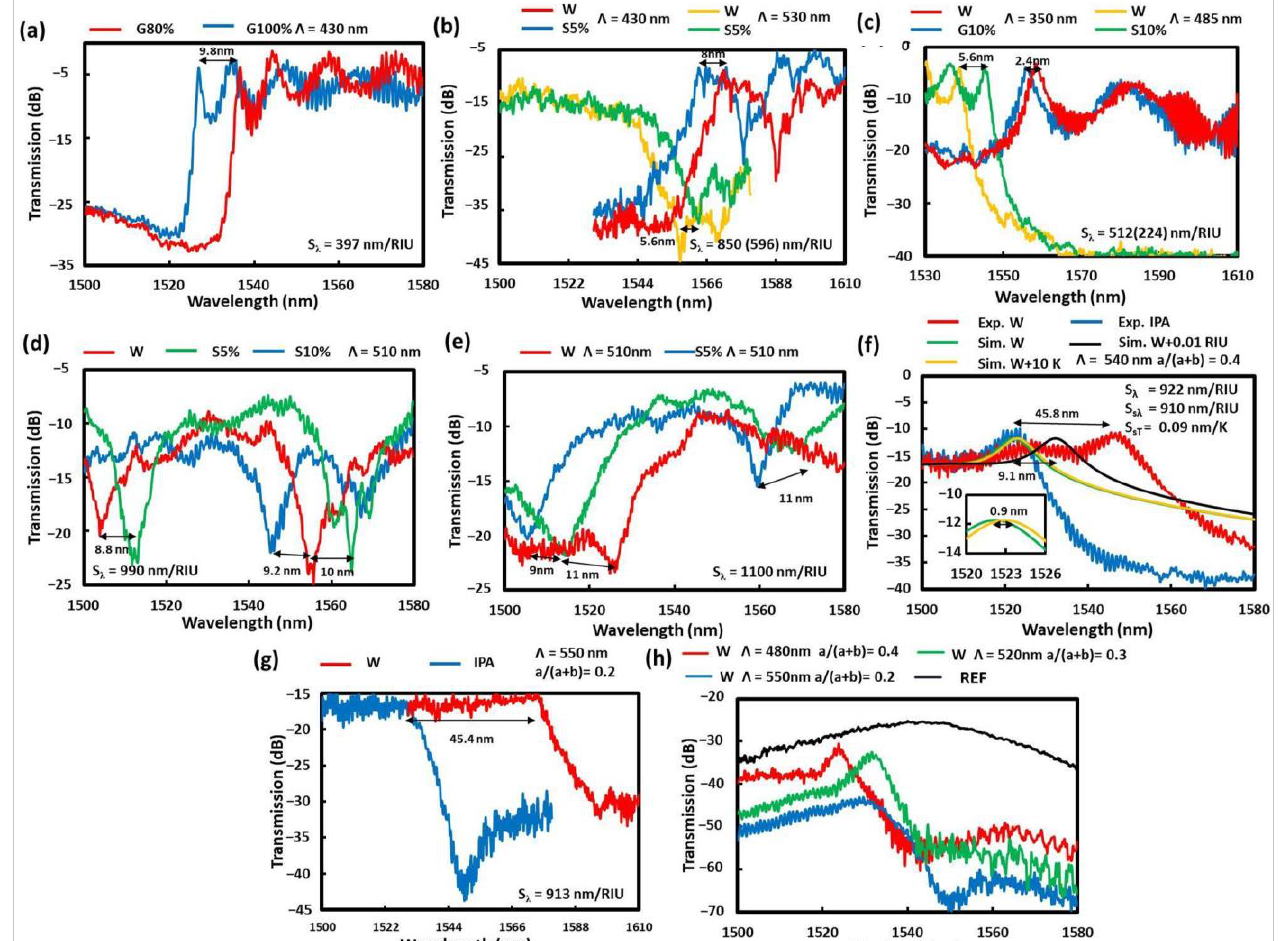
Figure 10. Measured transmission spectra for BG RI sensors with different surrounding medium liquids for ( a ) SW, ( b ) MS-SW, ( c ) suspended ladder, ( d ) CSAW by the lift-off method, ( e ) CSAW by the EBL inverse exposure with not fully etched holes, ( f ) with fully etched holes, and ( g ) SAW. ( h ) Measured SAW spectra for various duty ratios (a/(a + b)) in W medium. The surrounding media were W for water, Sx% (Gx%) for water with x weight concentration sugar (glycerol), and IPA for isopropyl alcohol. In ( f ) for CSAW, the simulated spectra are drawn as references for a sensing liquid with RI of pure water (W) at room temperature (RT), RI of W + 0.01, RIU at RT, and RI of W at RT + 10 K by green, black, and yellow lines, respectively.